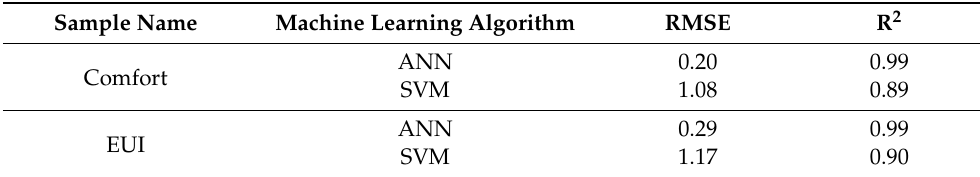
Table 6. Accuracy comparison of machine learning